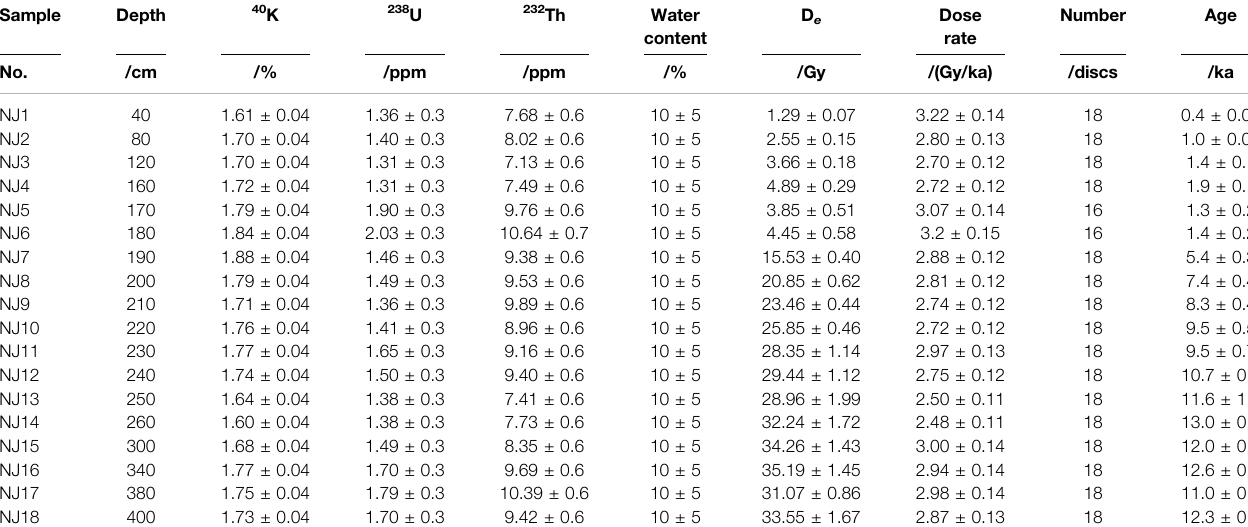
TABLE 1 | OSL dating results for section NJ, Gonghe Basin, NE-QTP.